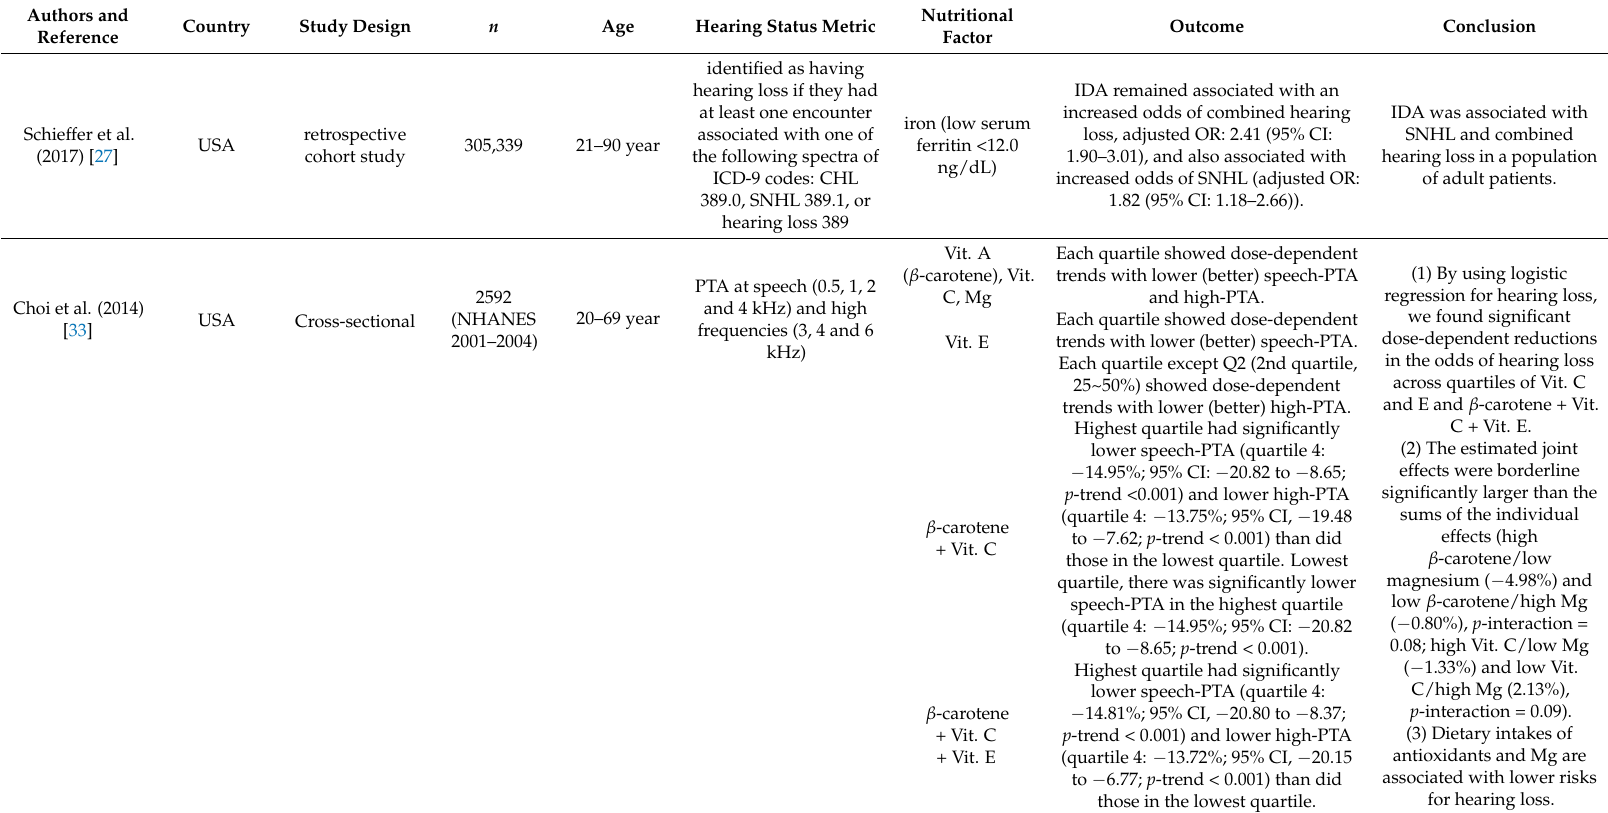
Table 1. Studies assessing the association between hearing status and a single